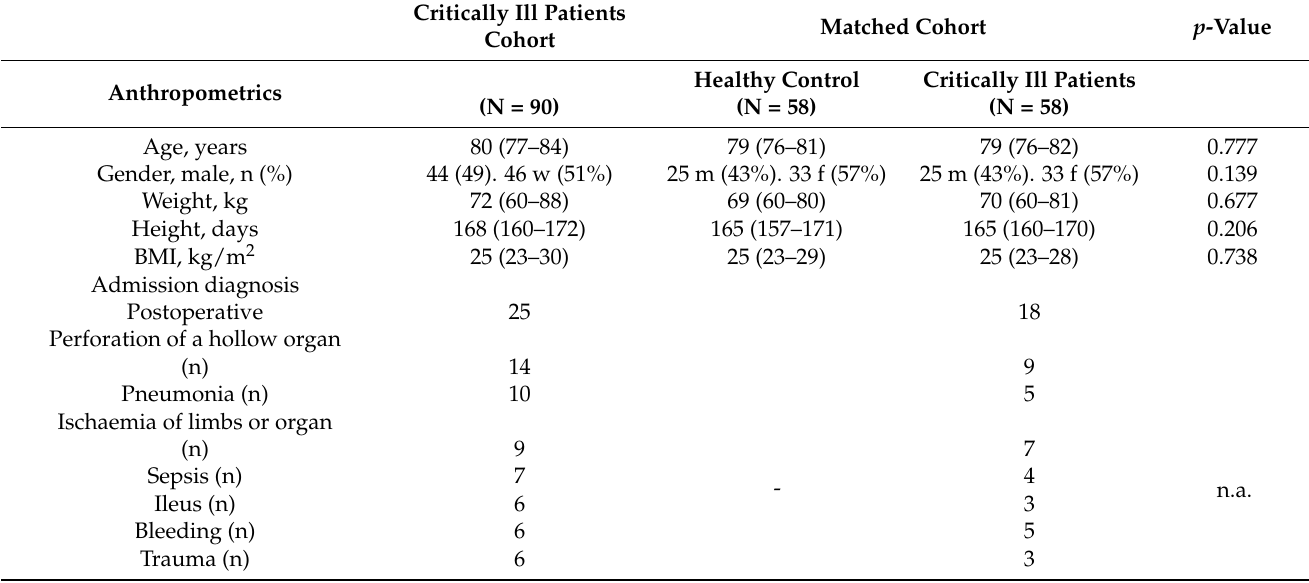
Table 1. Baseline characteristics and physiologic data of the critically ill patients cohort (N = 90) and matched cohort (with values given for N = 58 healthy controls and N = 58 critically ill patients). All values are expressed as medians with 25% and 75% percentiles. Abbreviations. ACS: acute coronary syndrome; APACHE: acute physiological and chronic health evaluation; REE: resting energy expenditure; FiO 2 : fraction of inspired oxygen; SOFA: sequential organ failure